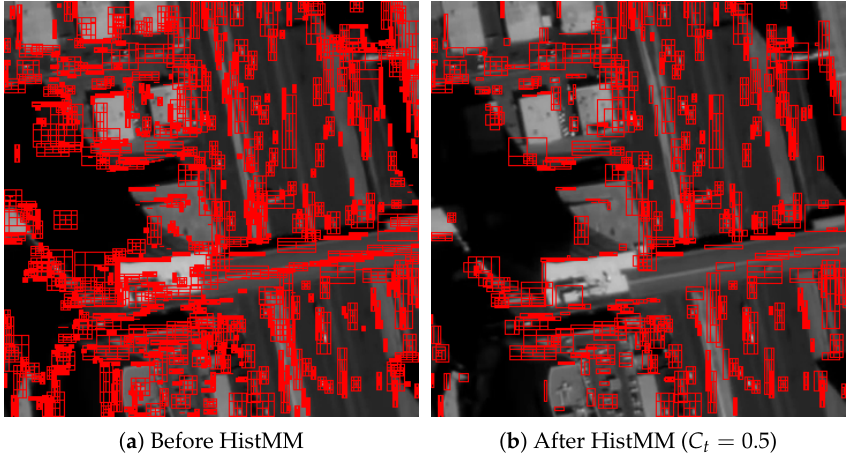
Figure 7. Visualization on region proposals before and after